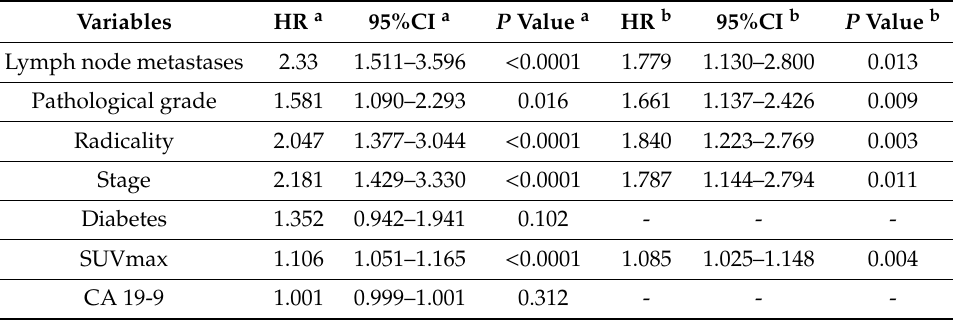
Table 2. Association Between Preoperative Variables and Disease-Free Survival on Univariate a and Multivariate b Cox Regression Model. HR = hazard ratio.